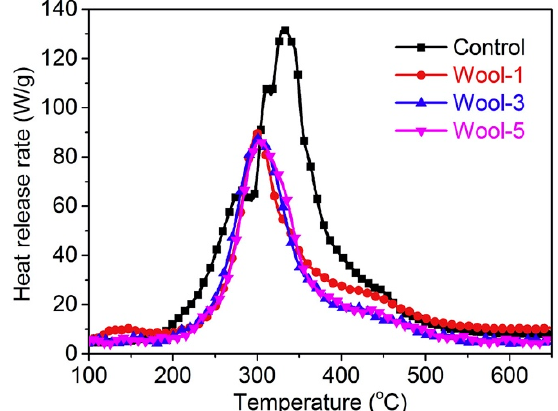
Figure 23. Heat Release Rate vs. temperature for untreated wool (“Control”) and for the fabric treated with the polyelectrolyte complex with different deposit times. Reprinted with permission from [52]. Copyright 2019, Elsevier.